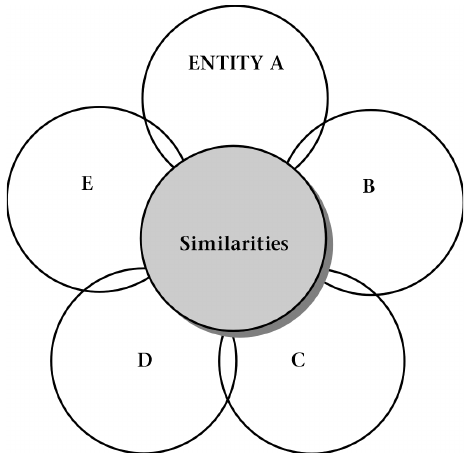
Figure 4: Similarities between